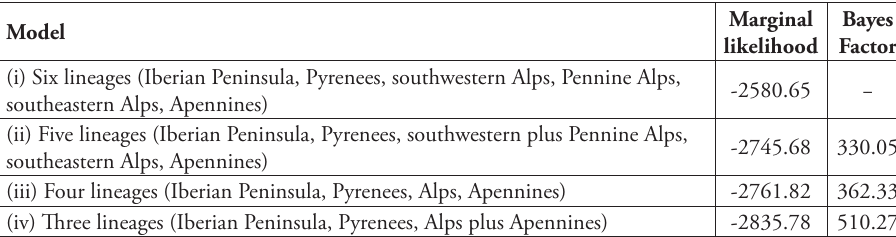
Table 1. Results for Bayesian lineage delimitation in Androscae vitaliana